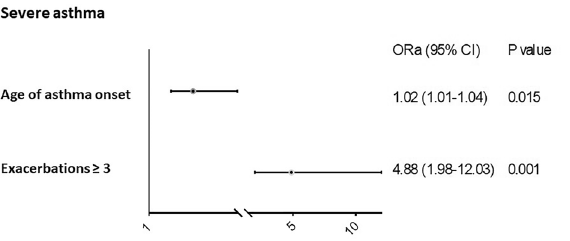
Figure 4. Factors associated with bronchiectasis in severe asthma patients. ORa: adjusted odds ratio. CI: confidence interval. Model: χ 2 = 18.82, p < 0.001. Model adjusted for gender, age group, atopy and sinusitis. Logistic regression was used to perform the